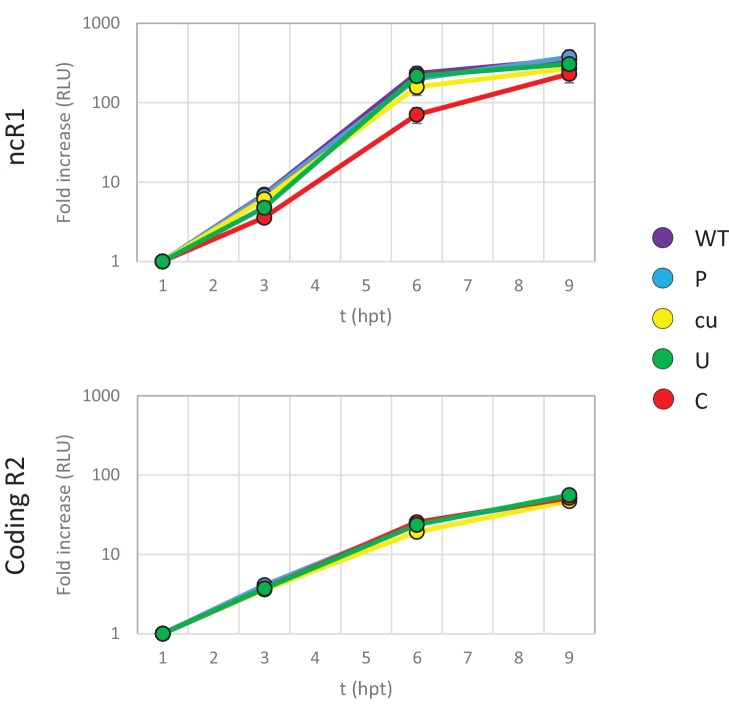
E7 replicon RNA replication with unfavourable dinucleotides in BHK cells.Replication efficiency of the E7 replicon RNA as measured by firefly luciferase expression. Non-coding region 1 (ncR1) or coding region 2 (R2) of wild type (WT), permutated (P), CpG and UpA low (cu), UpA high (U) and CpG high (C) composition were cloned into the E7luc replicon system and luciferase expression was measured at indicated hours post transfection (hpt). Data points represent the average of three biological replicates normalised to one hpt. Error bars represent one standard error of the mean.